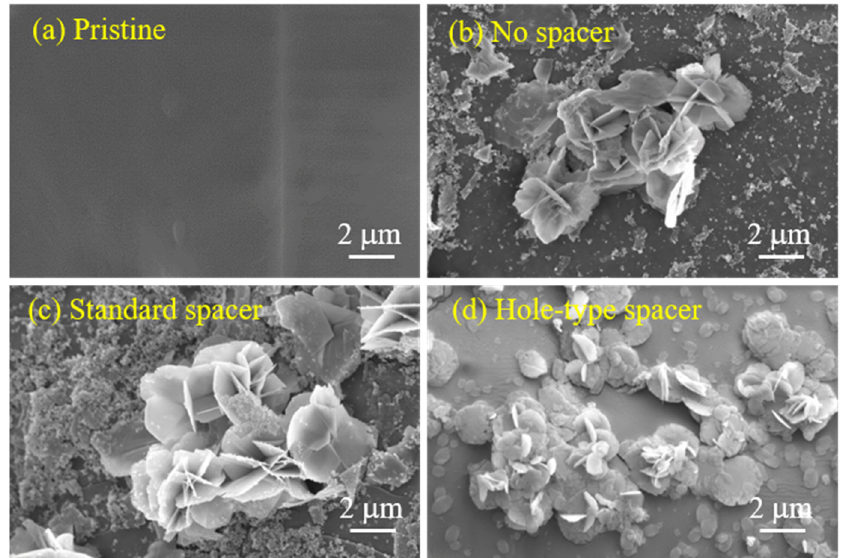
Figure 5. SEM images of the active layer surfaces of ( a ) pristine membrane, ( b ) membrane with no spacer, and membranes equipped with ( c ) standard and ( d ) hole-type spacers.